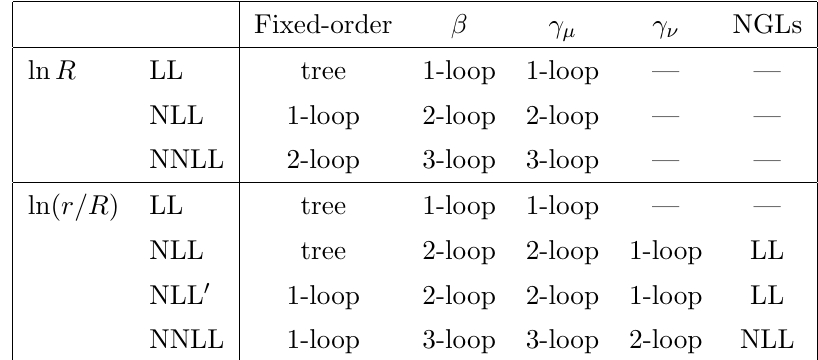
Table 1 . The perturbative ingredients needed at various orders in the ln R and ln( r=R ) resum- mation. The columns correspond to the loop order of the (cid:12)xed-order ingredients, the QCD beta function, the (cid:22) and (cid:23) anomalous dimensions, and the non-global logarithms. The non-cusp part of the (cid:22) anomalous dimension is only needed at one-loop order lower than indicated